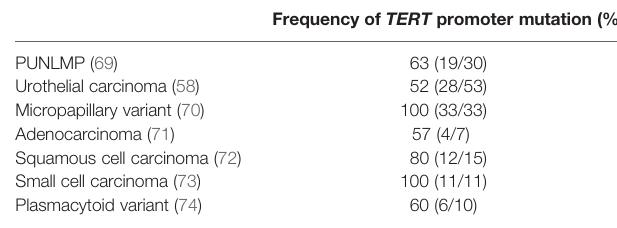
TABLE 1 | Frequency of TERT promoter mutation in different types of bladder tumor, including those with rare variant histology.